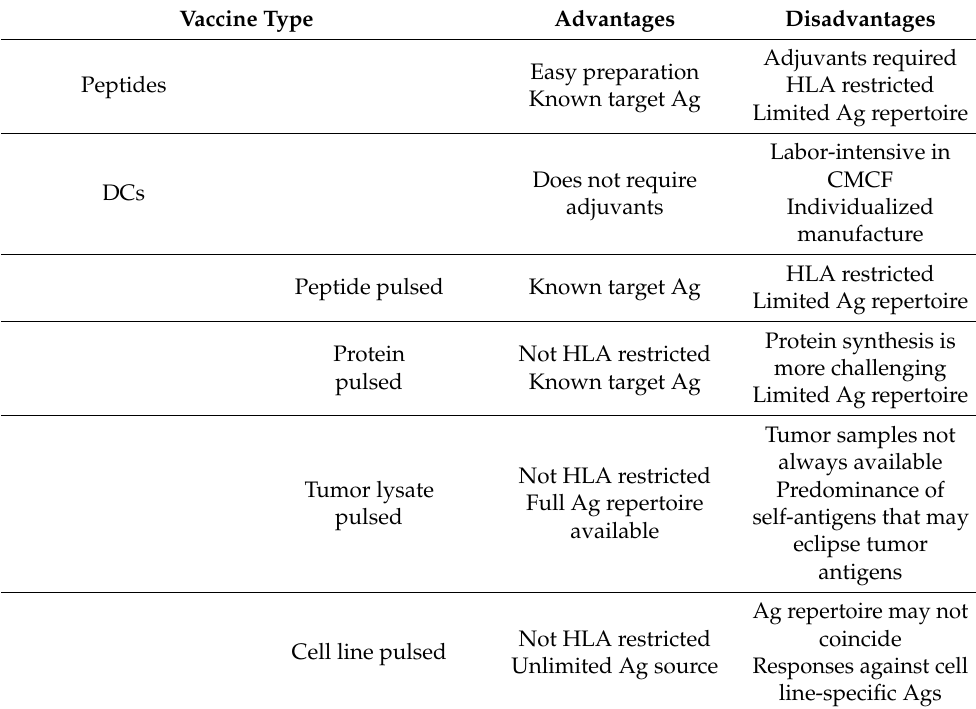
Table 3. Advantages and disadvantages of vaccination strategies used in